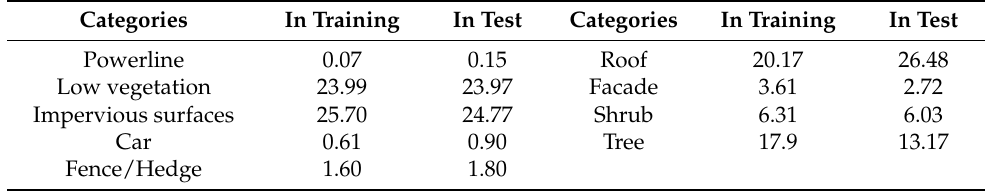
Table 1. The percent of different categories in ISPRS dataset (in